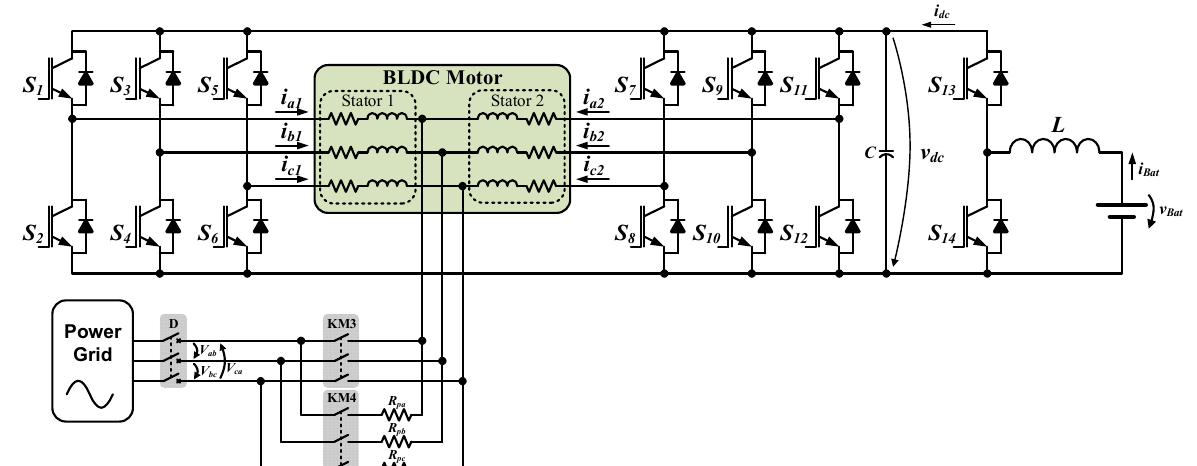
Figure 7. Proposed unified power converter topology.